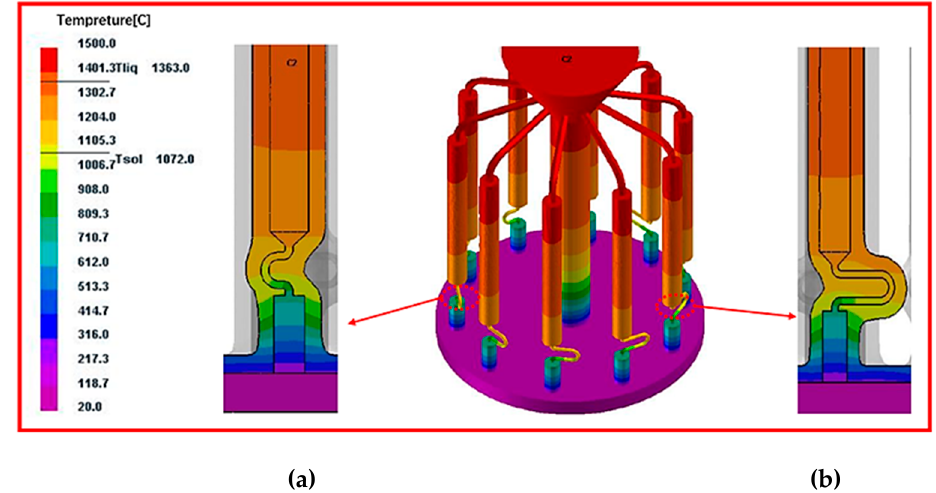
Figure 5. Simulation results of temperature field distribution and the morphology of solid-liquid interface of grain selector with different diameters without enclosure and the cross-section of ( a ) d w = 2.4 mm; and ( b ) d w = 4 mm.